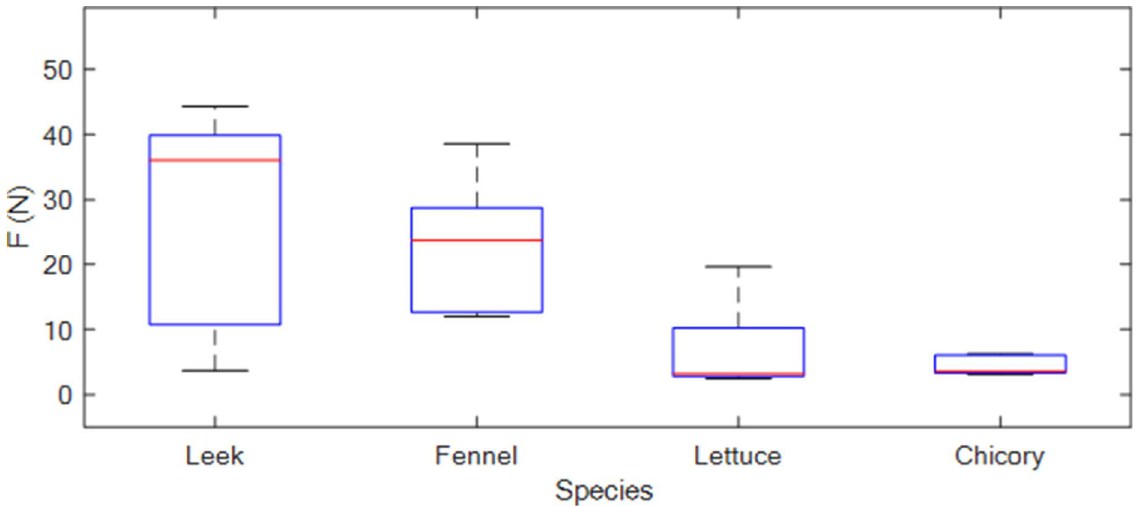
Figure 5. Boxplot of the force needed to detach the seedlings from their trays. It is noticeable that the forces applied on leek and fennel seedlings are about one order of magnitude greater than the forces on lettuce and chicory (Figure 5). This effect is related to the root systems of leek and fennel, which form a strong bond with the tray. In trial 2 (the plug-lifting experiment), the two grippers have been tested on four dif- ferent vegetable seedling species for their capacity to lift seedling plugs from a tray. With both grippers, lifting was successful on almost all seedlings that had been detached from the tray beforehand without compromising the plugs’ soil structures. Only one exception was observed: when lifting leek seedlings by grasping the soil of the plugs with the needle gripper, the soil frequently got detached from the roots and was solely lifted without the plant or even shattered. However, the needle gripper was not able to lift seedlings out of their trays if they havd not been detached prior since the adhesive force exceeded the lifting force. Likewise, using the two-finger gripper leek and fennel seedlings that had not been detached prior caused problems. The fingertips slid along the stems upwards with- out detaching the plugs from the tray. Yet, the lifting of chicory and lettuce seedlings through the two-finger gripper without prior detachment was mostly successful. The lift- ing force progressions of the latter are shown in Figure 6. The lifting starts at 2 s, when the actuator moves upwards with the constant velocity of 5 mm/s until it reaches its final position at 9 s.